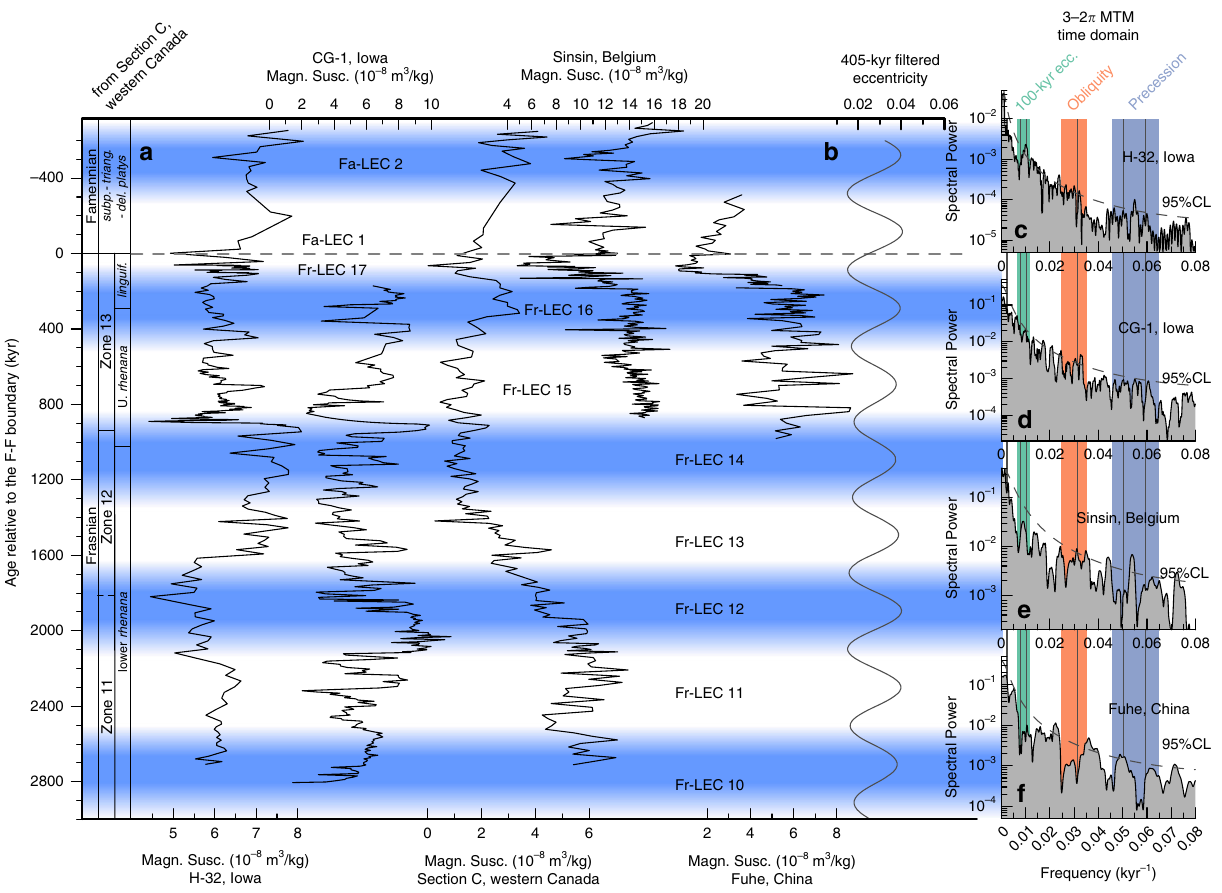
Fig. 2 Late Frasnian – earliest Famennian magnetic susceptiblity data from globally distributed sections along a common astronomically constrained relative timescale. a The H-32, CG-1, Sinsin, and Fuhe records have been tied-in into the Frasnian astrochronologic framework for Section C (western Canada) and Kowala (Poland), based on distinct features in magnetic susceptibility and carbon isotope geochemistry (Figs. 5 and 6). The Frasnian astrochronogic framework counts 16.5 long 405-kyr eccentricity cycles (Fr-LEC) 15 – 17 . The fi rst Famennian 405-kyr cycle (Fa-LEC 1) is the same cycle as Fr-LEC 17. b The 405-kyr eccentricity fi lter is derived from the La2004 solution 68 , and plotted according to the phase relationships discussed in this study. c – f Multitaper method (MTM) power spectra of the tied-in records show peaks at or close to the expected frequencies of 100-kyr eccentricity (ecc.), obliquity and precession. Vertical lines across power spectra indicate the expected astronomical frequencies at 375 Ma, as calculated by Berger et al. 26 . linguif. linguiformis, subp. subperlobata, triang. triangularis, del. platys delicatula